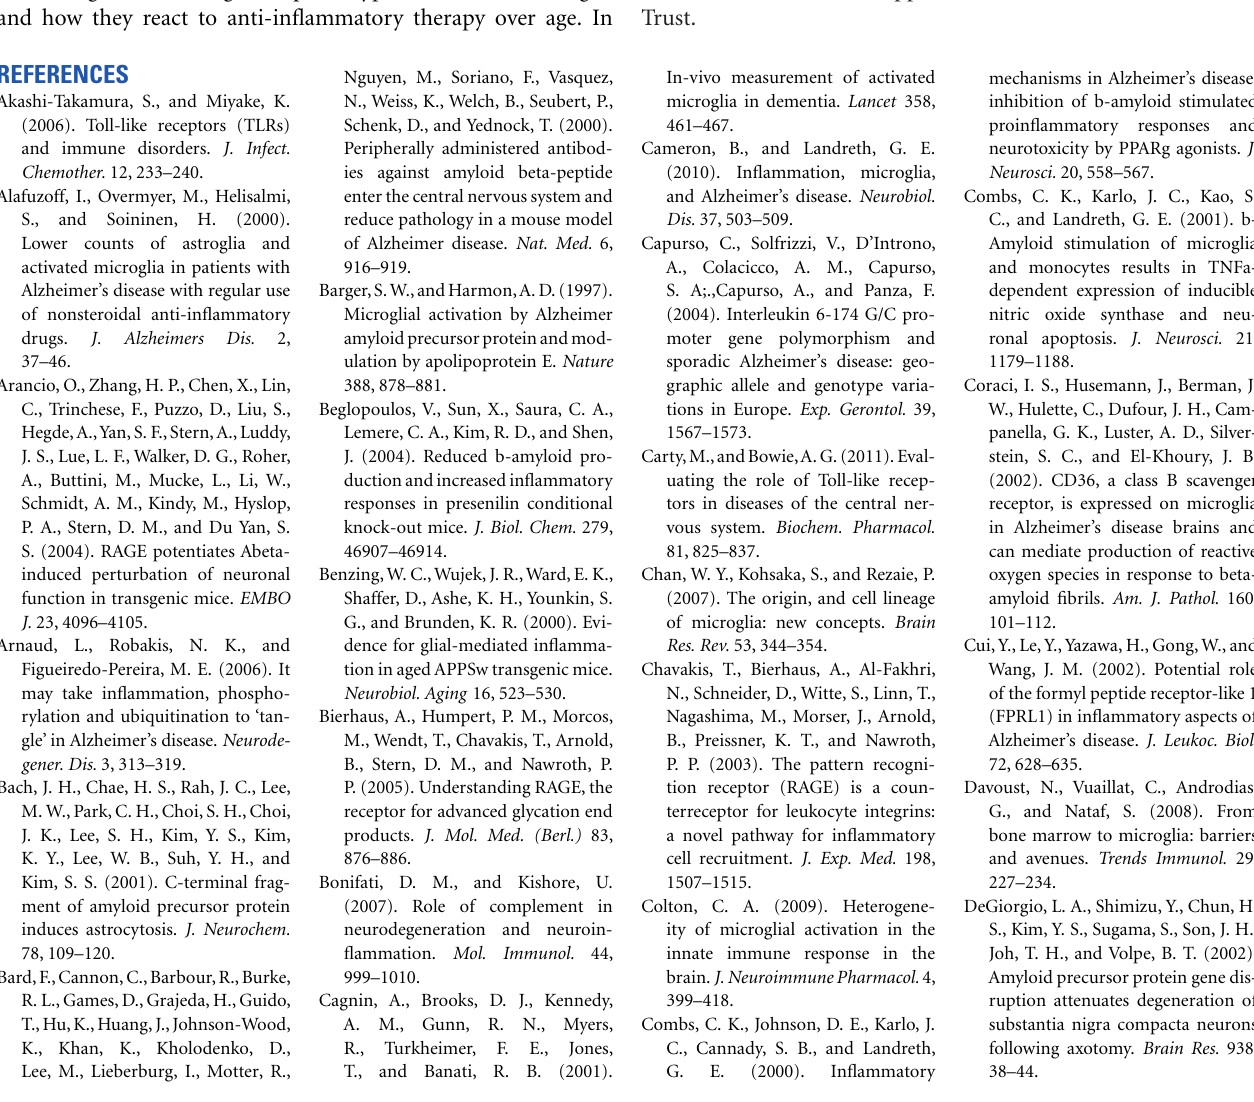
to investigate the changes in phenotype of resident microglia and how they react to anti-inflammatory therapy over age.